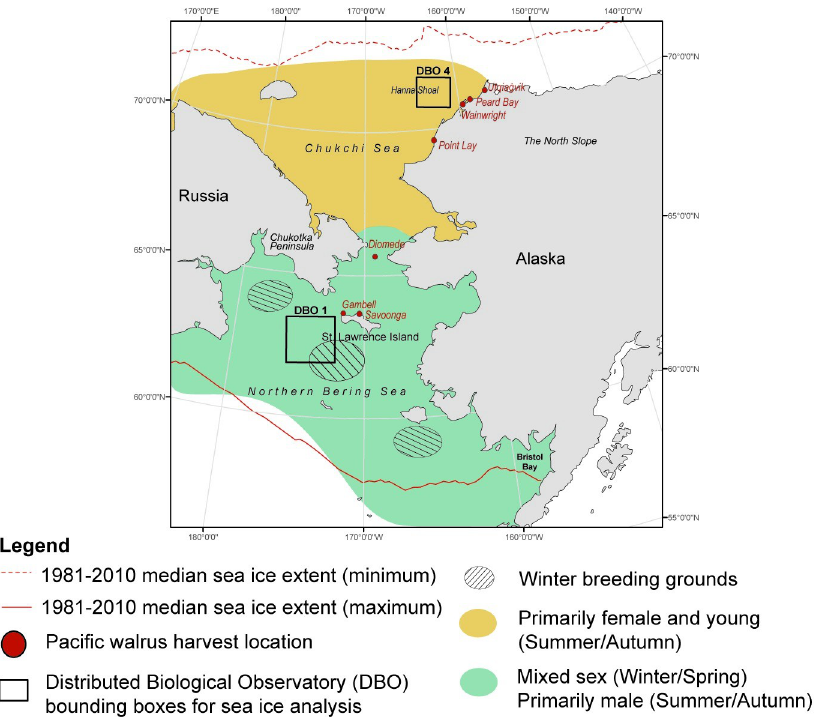
Fig 1. The Pacific walrus geographical range and sample harvest locations. Pacific walrus liver tissues were collected by subsistence hunters from several communities in the Bering Strait and from the North Slope of Alaska. The range of the Pacific walrus spans the northern Bering and Chukchi Seas, with sex-segregated distributions throughout the year (green/yellow shading). The Distributed Biological Observatory regions 1 and 4 (boundaries denoted by the black boxes; Grebmeier et al. [4]) encompass prominent Pacific walrus breeding and foraging grounds, which were used for extracting satellite-derived sea ice measurements and nitrogen stable isotope data for primary consumers from previous studies for the relative trophic position analysis. Pacific walrus range data was modified from Garlich-Miller et al. [22] and Smith [23]. Open-source coastline data was retrieved from Natural Earth (https://www.naturalearthdata.